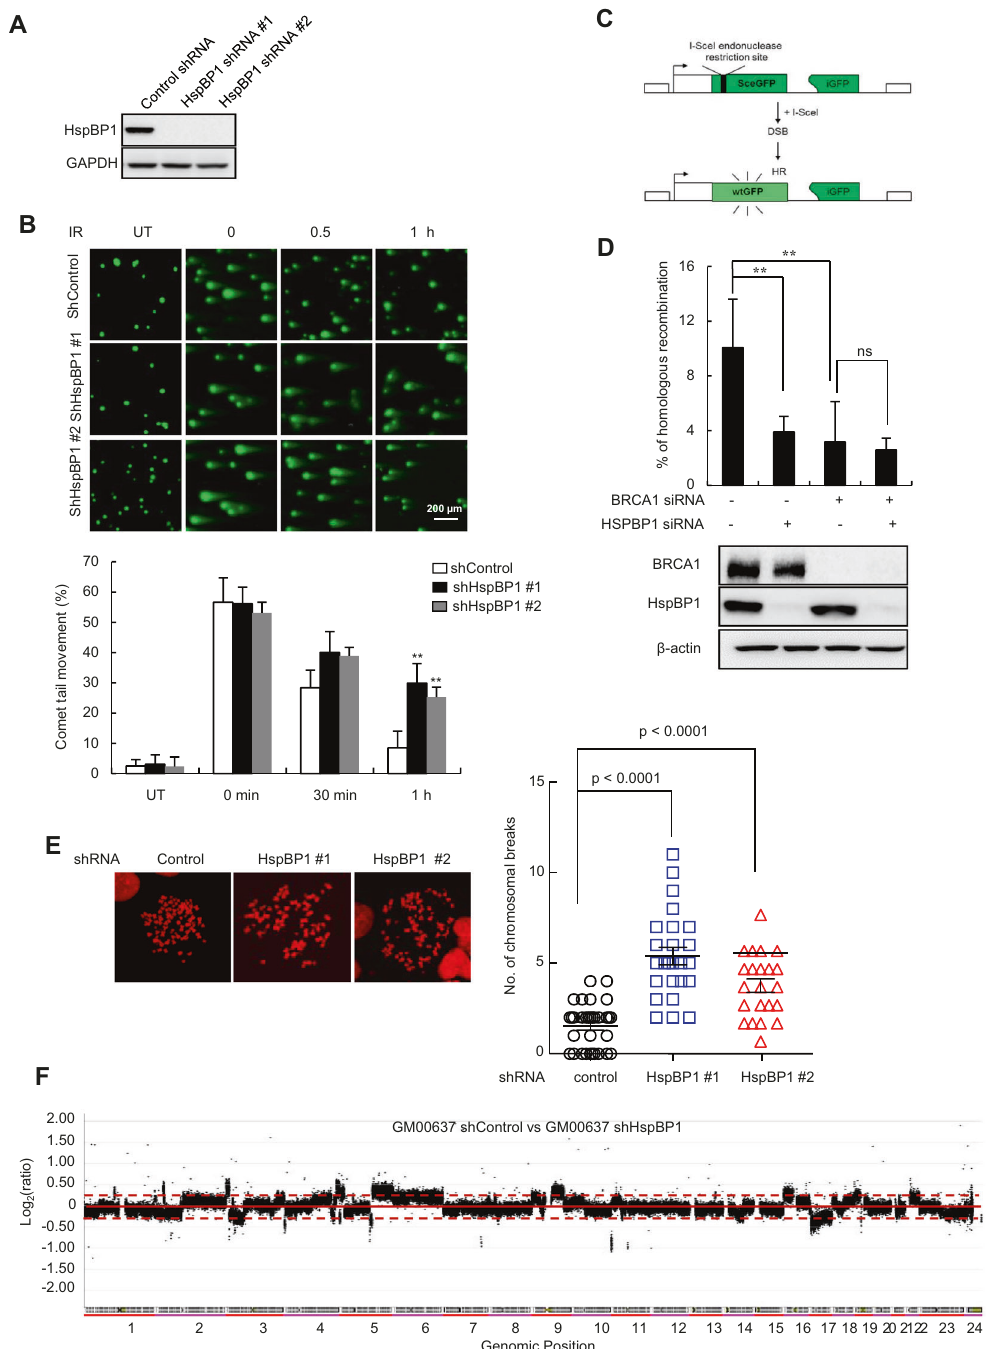
Fig. 4 HspBP1 knockdown results in decreased DSB repair and increased chromosomal instability. A Immunoblot analysis of HspBP1 from a stable knockdown of HspBP1 using two different shRNAs in U2OS cells. B Control or HspBP1-depleted U2OS cells were either untreated (UT) or treated with 5 Gy of IR. At the indicated time points, cells were harvested for comet tail formation assays under neural conditions. Representative images and quanti fi cation of unrepaired DSBs are shown and data are presented as mean ± SD ( n = 3), ** P < 0.01, two-tailed Student ’ s t -test. C A schematic diagram of the fl uorescence-based assay for measuring levels of HR-mediated DSB repair. D The ef fi ciency of HR repair was measured by FACS analysis in DR-GFP-U2OS cells transfected with indicated combinations of siRNA. Levels of endogenous HspBP1 and BRCA1 were analyzed by western blotting and data are shown as mean ± SD ( n = 3). ** P < 0.01. ns, not signi fi cant, two-tailed Student ’ s t-test. E Control and HspBP1 knockdown U2OS cells were treated with 2 Gy of IR and chromosome aberrations were measured using metaphase chromosome spreads. Representative images and quanti fi cation of chromosome breaks are shown. P values between the indicated samples were calculated using a Mann-Whitney test. ns not signi fi cant. F Array CGH pro fi les of GM00637 cells transfected with control shRNA versus HspBP1 shRNA. Chromosomal regions above or below the dotted line indicate ampli fi cations or deletions of genomic regions,